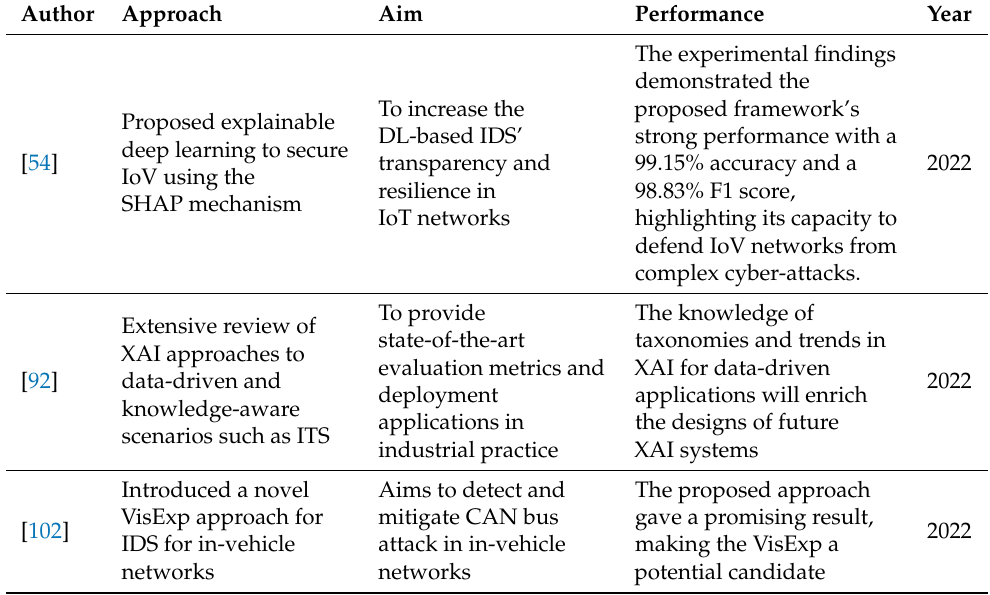
Table 3. Publications on XAI-based IDS solutions for